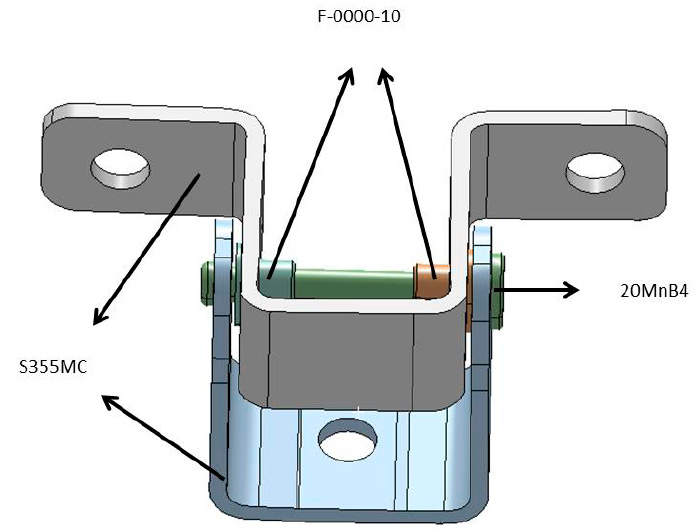
Figure 9. Material assignment for the components.